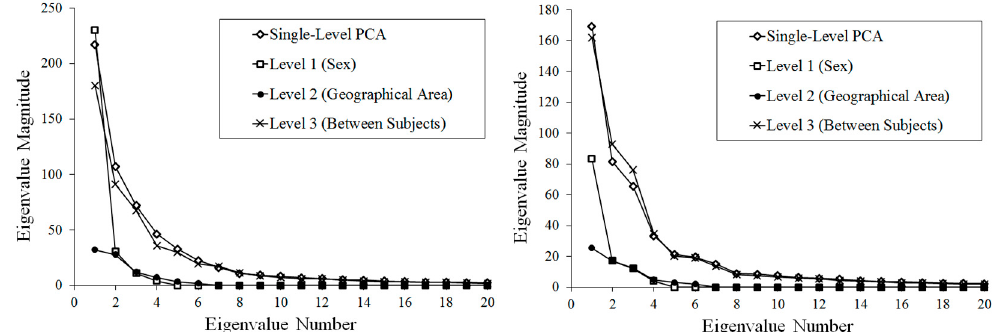
Figure 4. Eigenvalues from single-level principal components analysis (PCA) and multilevel Principal Components Analysis (mPCA): ( left ) Unscaled shape data; ( right ) scaled data (i.e., all shapes were resized to a common length scale).